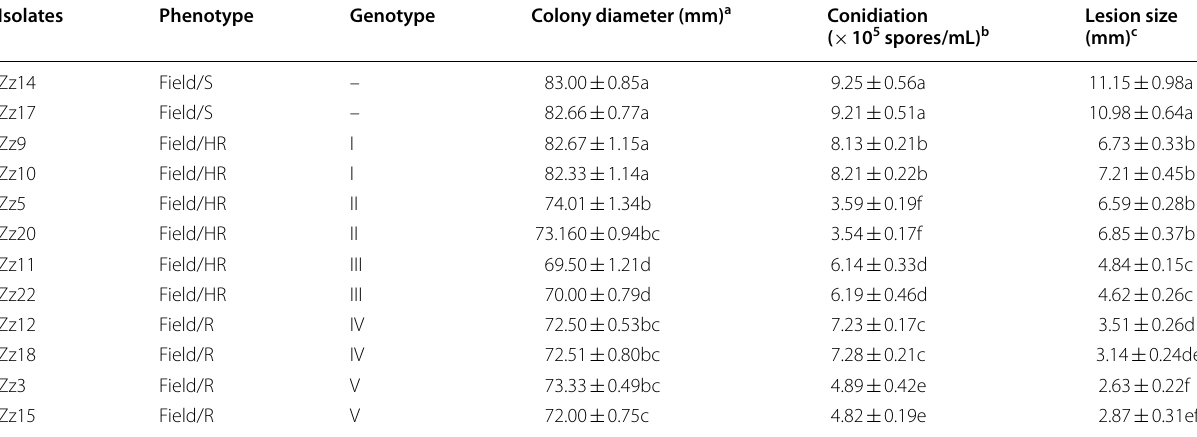
Values are the means standard deviations from three replicate experiments. Different letters indicate significant differences according to the Fisher’s LSD test at ± P 0.05. a The isolates were grown on PDA medium, and colony diameter of each isolate was measured after 5 days of incubation at 25 °C. b The sensitive and resistant = isolates were incubated in PDB medium for 5 days at 25 °C, and conidia produced by each isolate were collected and determined using a hemocytometer. c Mycelial plugs of each isolate were inoculated on wounded chili fruits, and lesion sizes were measured after 7 days of incubation. Each isolate was inoculated on 15 chili